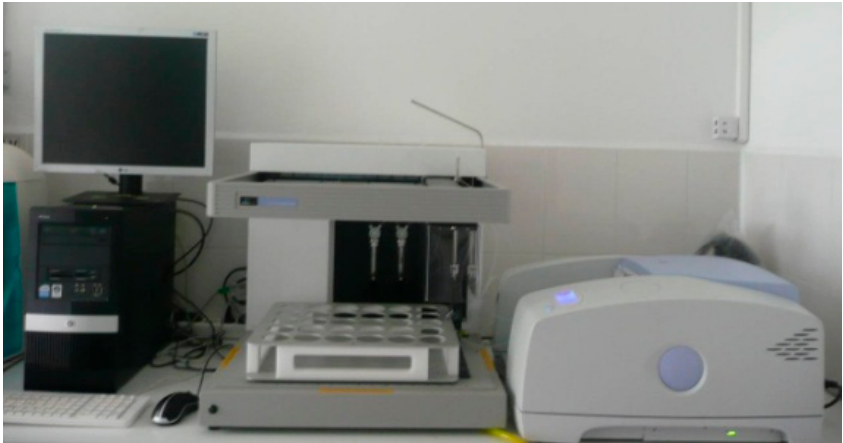
Figure 7. Fourier transform infrared (FTIR) Spectrum OilExpress Series 100, v 3.0 spectrometer.